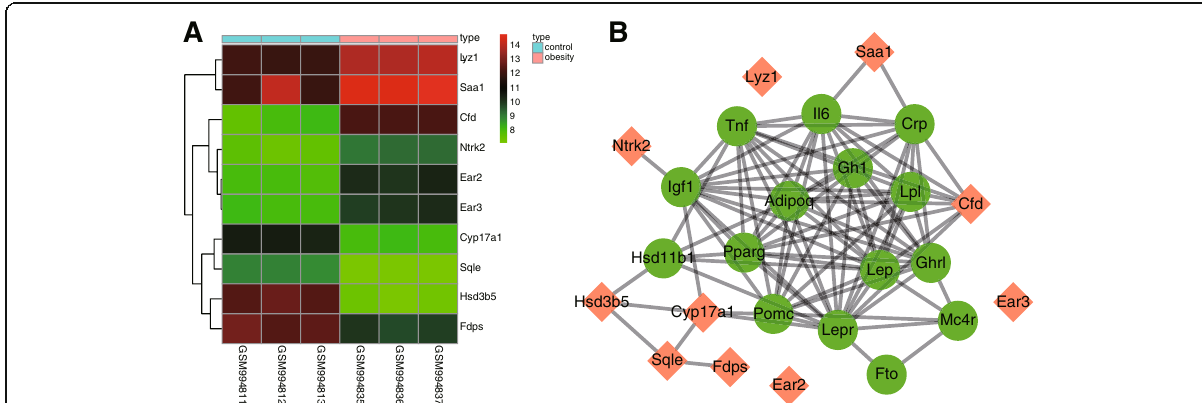
Fig. 1 SAA1 is associated with HFD-induced obesity. a , the heatmap of the top 10 DEGs screened out from the GSE39549 dataset. The abscissa indicates the sample number, the ordinate indicates the DEGs, and the upper right histogram is the color gradation. Each rectangle corresponds to value of one sample expression; b , the interaction network between the DEGs and obesity-related genes. Orange indicates DEGs and green indicates obesity-related genes. Cyp17a1, cytochrome P450, family 17, subfamily a, polypeptide 1; Cfd, complement factor D; SAA1, serum amyloid A protein 1; DEGs, differentially expressed